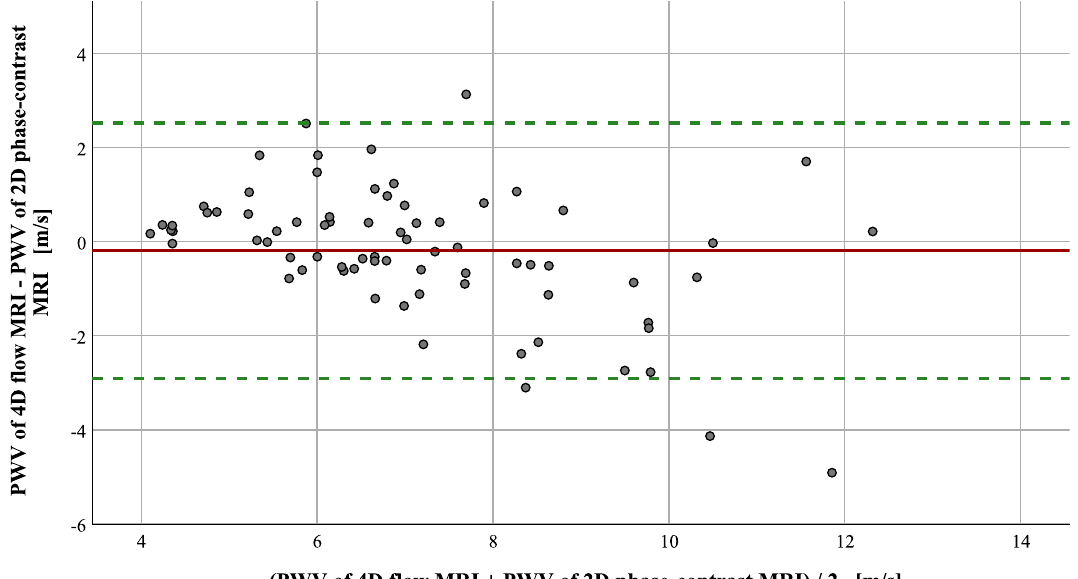
Figure 5. Comparison of PWV determined by 4D flow versus 2D phase-contrast MRI at follow-up. The Bland– Altman plot demonstrates that values of 2D phase-contrast MR angiography were minimally higher compared to values from 4D flow MRI (mean (solid line) = − 0.19; 1.96 × standard deviation (= 1.38) results in + 2.53 (upper limit, dashed line) and − 2.90 (lower limit, dashed line). This comparison of both MRI methods was possible in 74